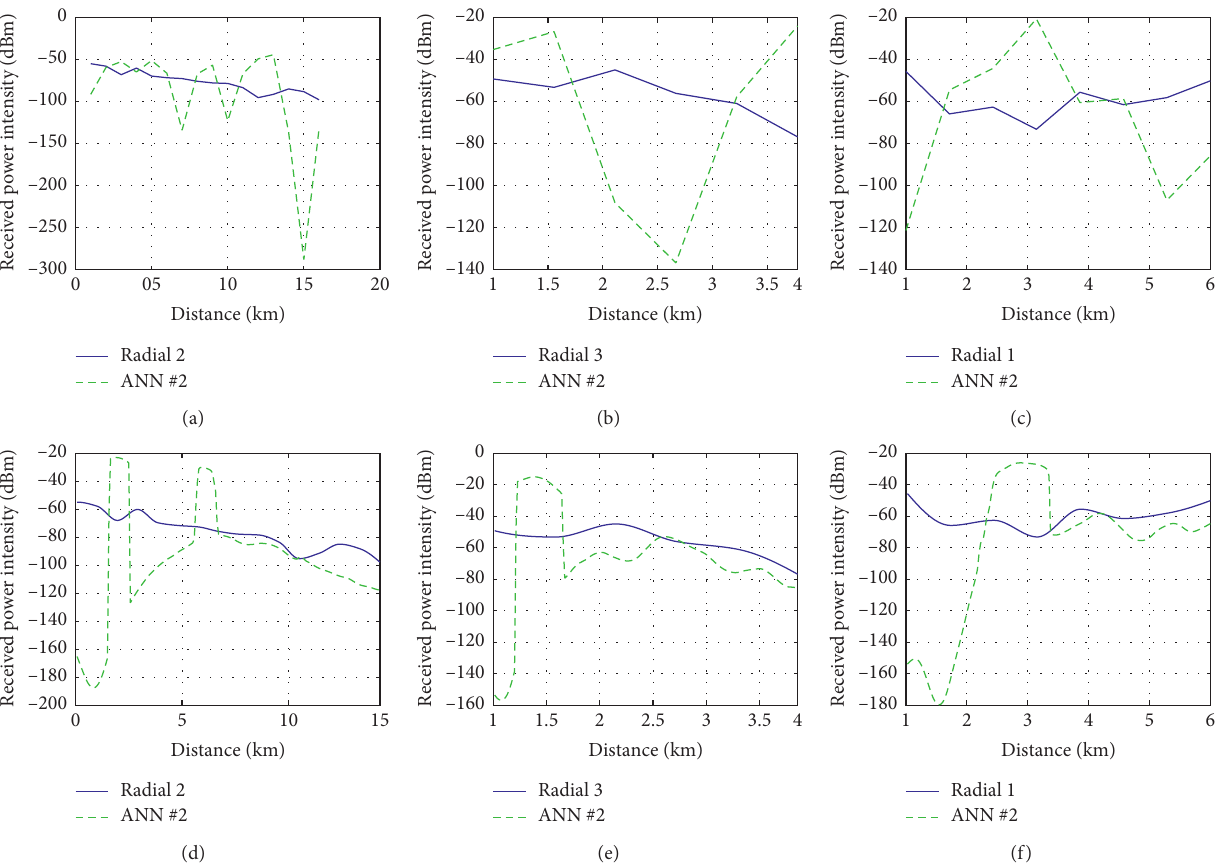
Figure 11: Exponential combination for original radial 2 (a); original radial 3 (b); original radial 1 (c); interpolated radial 2 (d); interpolated radial 3 (e);and interpolated radial 1